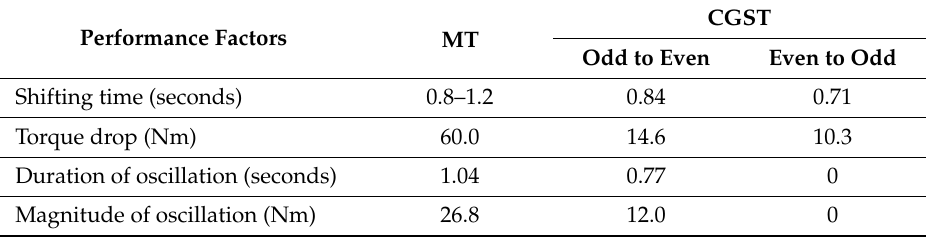
Figure 16. Comparisons of output torque profiles of manual transmission (MT) and CGST. Table 5. Performances of the CGST and comparisons with the manual